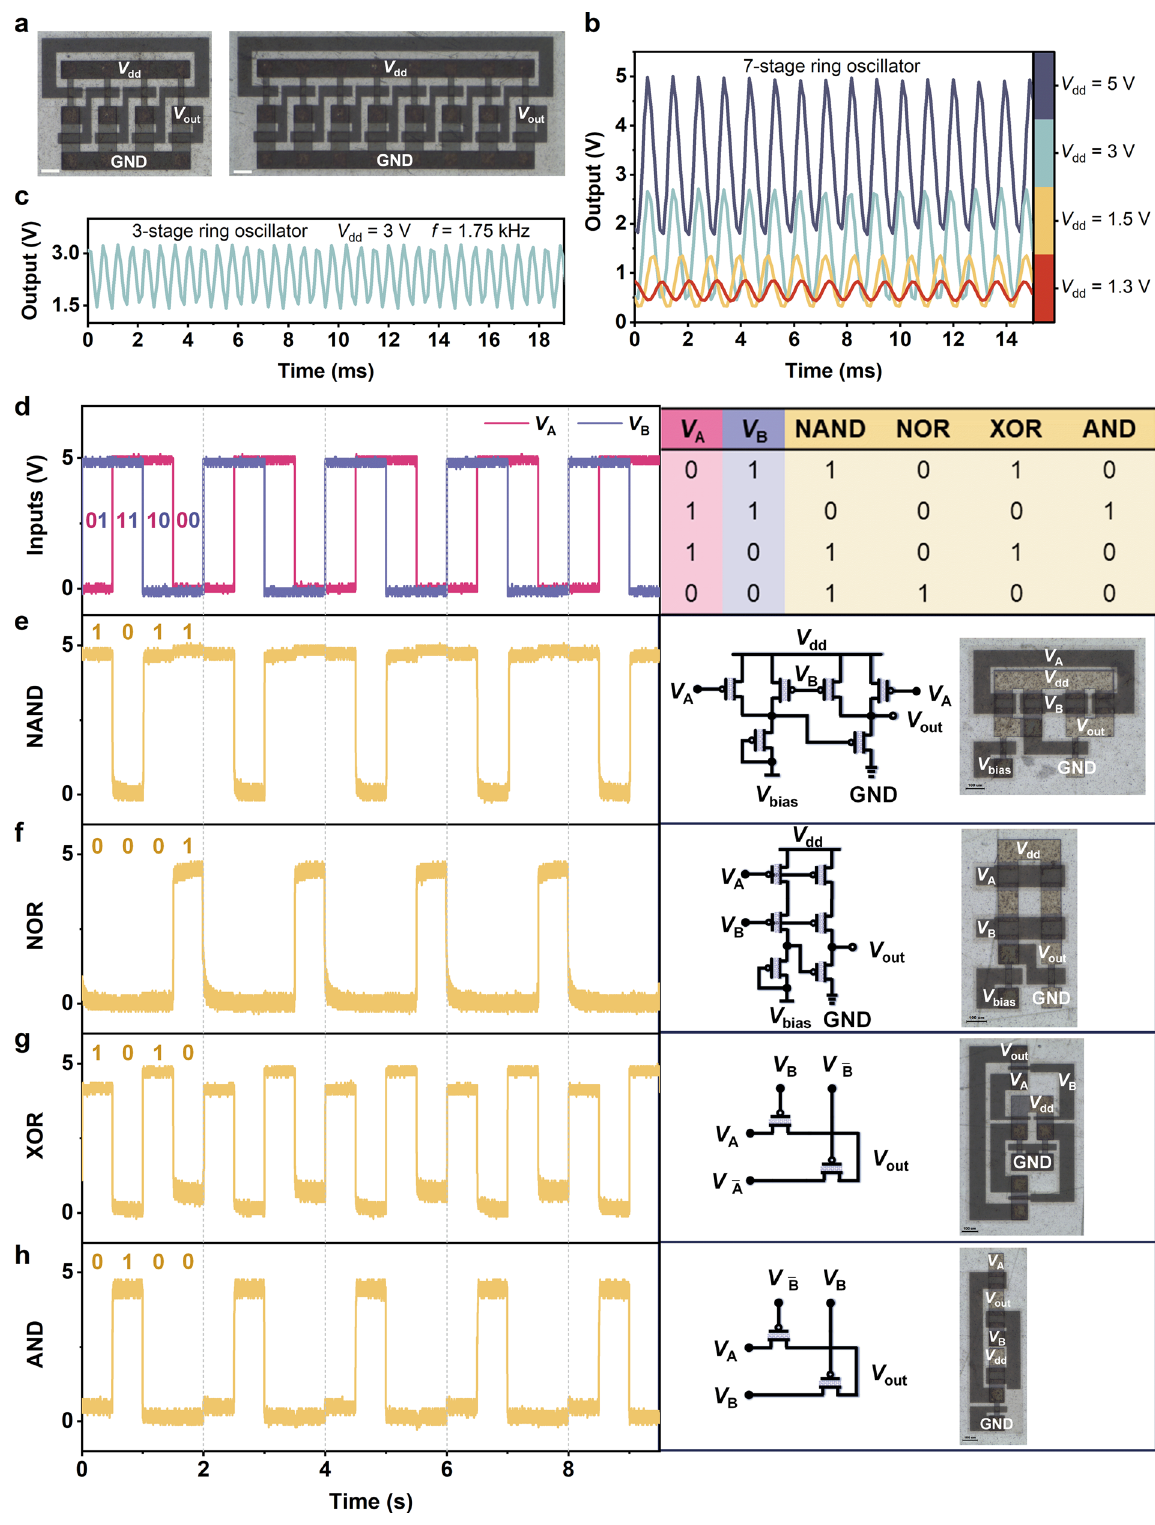
Fig. 6 Ring oscillators and logic circuits. a Optical images of the 3-stage and 7-stage ring oscillators (scale bar 100 μ m). b Output waveform of the 7-stage ring oscillator with various V dd from 5 to 1.3 V. c Output waveform of the 3-stage ring oscillator with an oscillation frequency of 1.75 kHz. d Input, truth table, and output waveforms of the e NAND, f NOR, g XOR, and h AND gates. The corresponding optical images and circuit diagrams are shown on the right (scale bar 100 μ